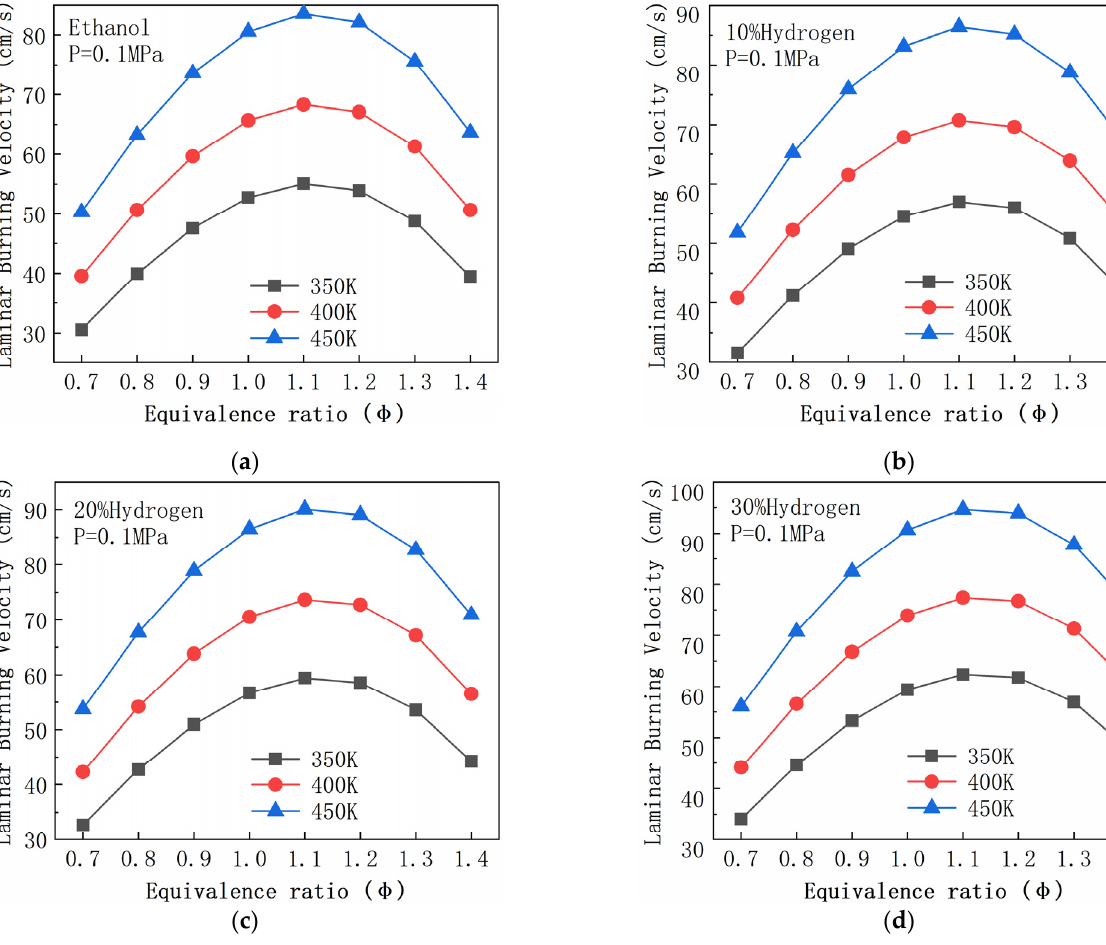
Figure 7. LBVs at different initial temperature and P0 = 0.1 MPa: ( a ) ethanol, ( b ) 10% hydrogen, ( c ) 20% hydrogen, and ( d ) 30%